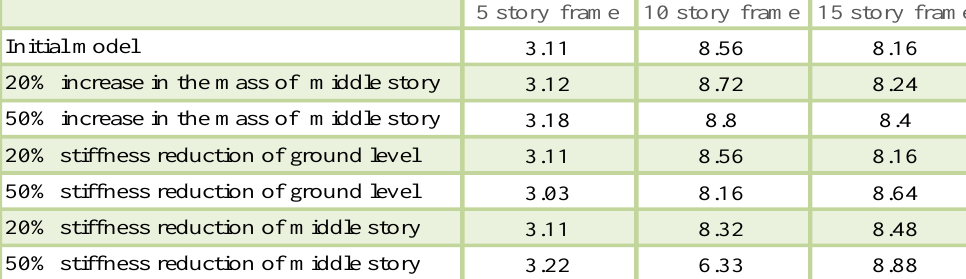
Fig. 14. time history of maximum displacement of roof 15 story with 50% stiffness reduction of middle story. Maximum displacement of roof story in time history